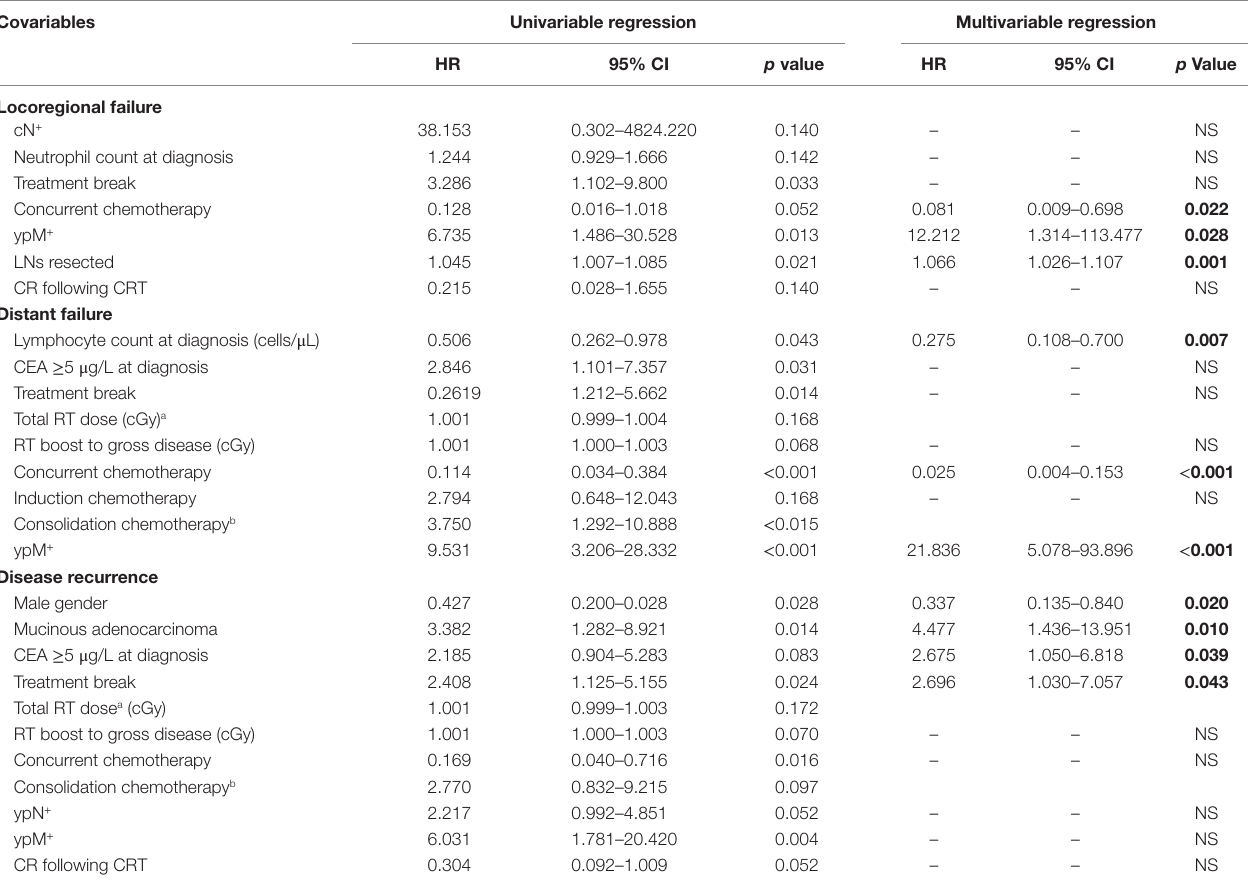
TaBle 5 | Univariable and multivariable analysis of long-term oncologic